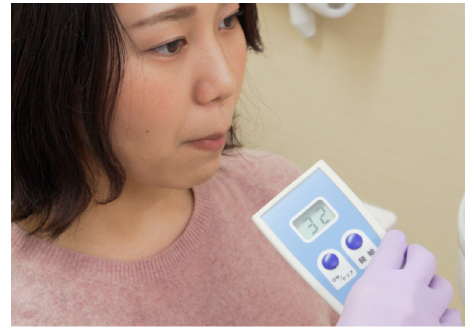
Figure 4. Oral moisture checker. Nutrients 2020 , 12 , x FOR PEER REVIEW